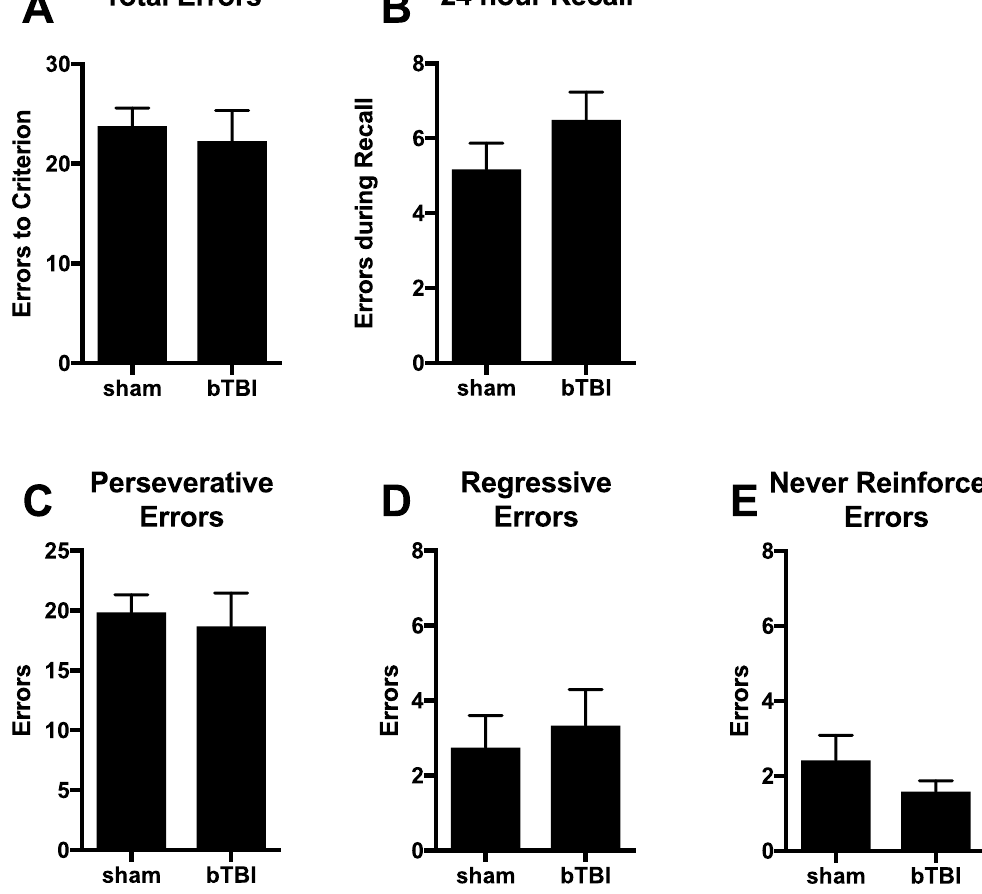
Figure 3. Performance in shift to response discrimination. ( A ) Number of errors committed during acquisition of set shift. ( B ) Number of errors committed in a 20-trial recall test performed 24 hours following acquisition criteria were met. ( C – E ) Analysis of error type during acquisition of set shift: ( C ) Perseverative errors, ( D ) Regressive errors, ( E ) Never reinforced errors. Bars represent mean ± SEM. N =